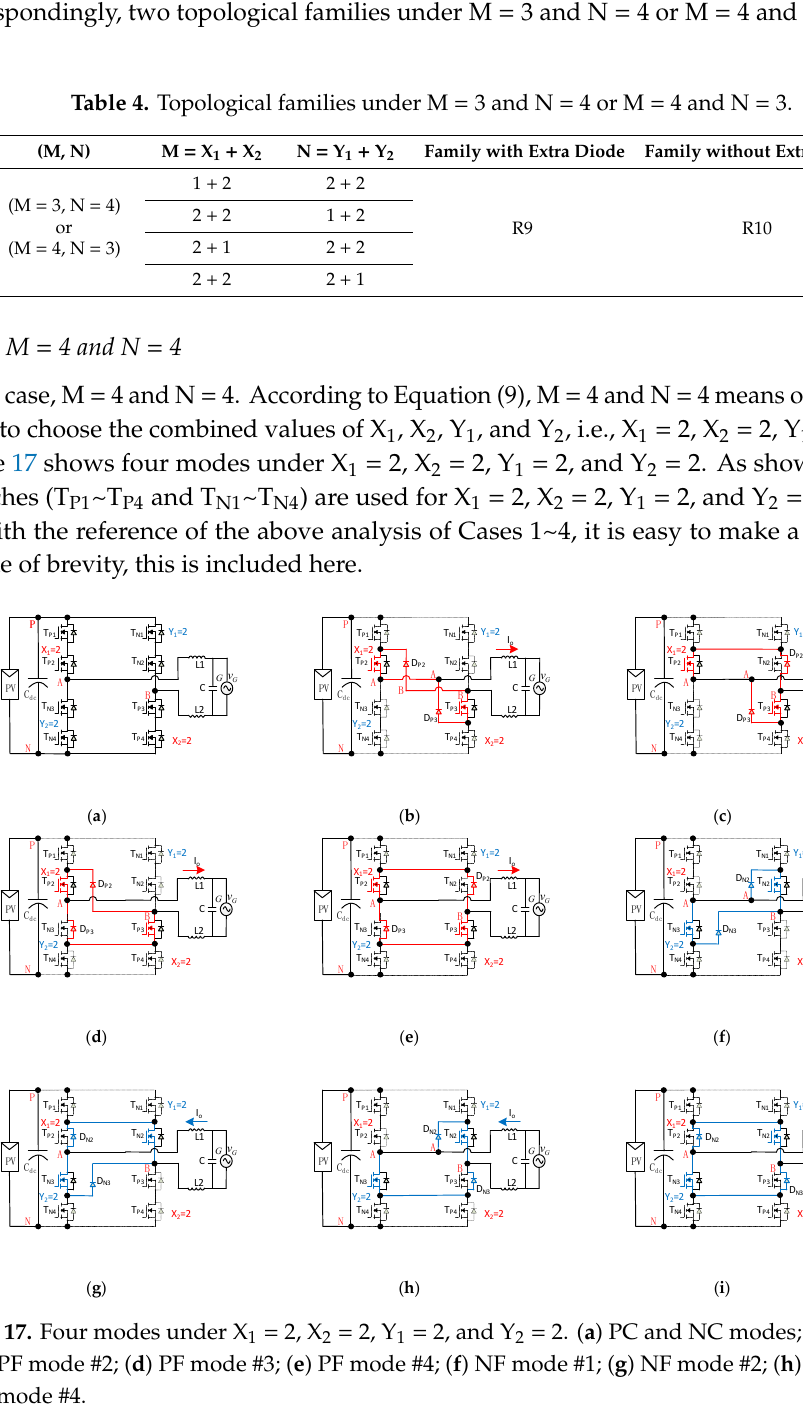
( c ) Figure 18. Four topologies derived from X 1 = 2, X 2 = 2, Y 1 = 2, and Y 2 = 2. ( a ) R11 (new); ( b ) R12 (new); ( c ) R13 [17]. Two corresponding topological families under M = 4 and N = 4 are shown in Table 5. Table 5. Topological families under M = 4 and N = 4. (M, N) M = X 1 + X 2 N = Y 1 + Y 2